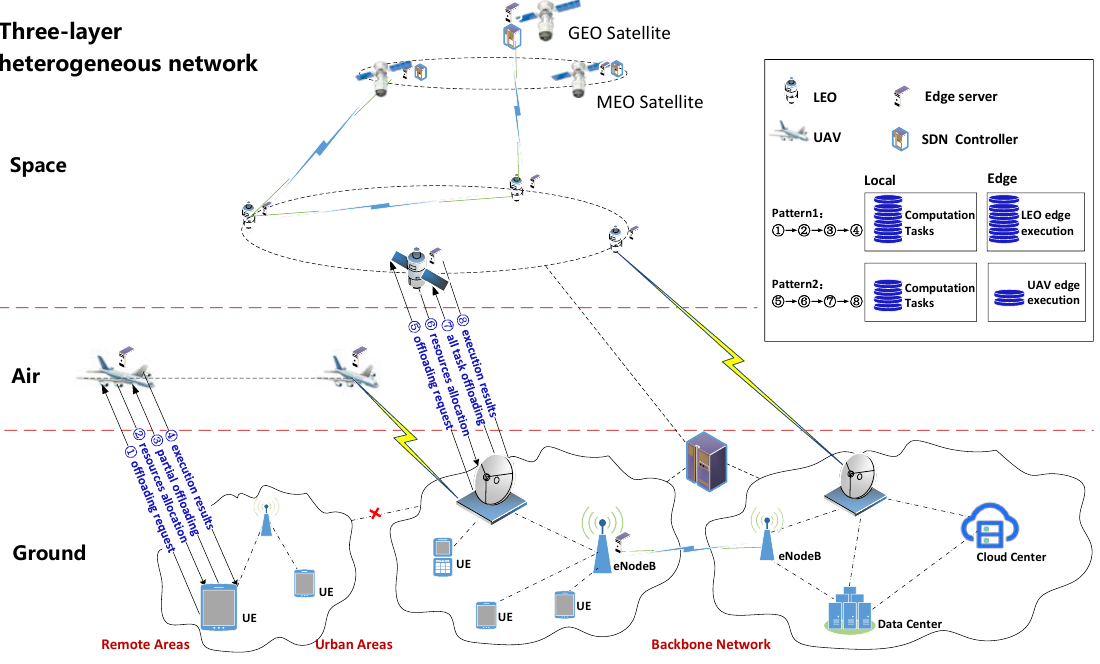
Figure 1. SAGIN system